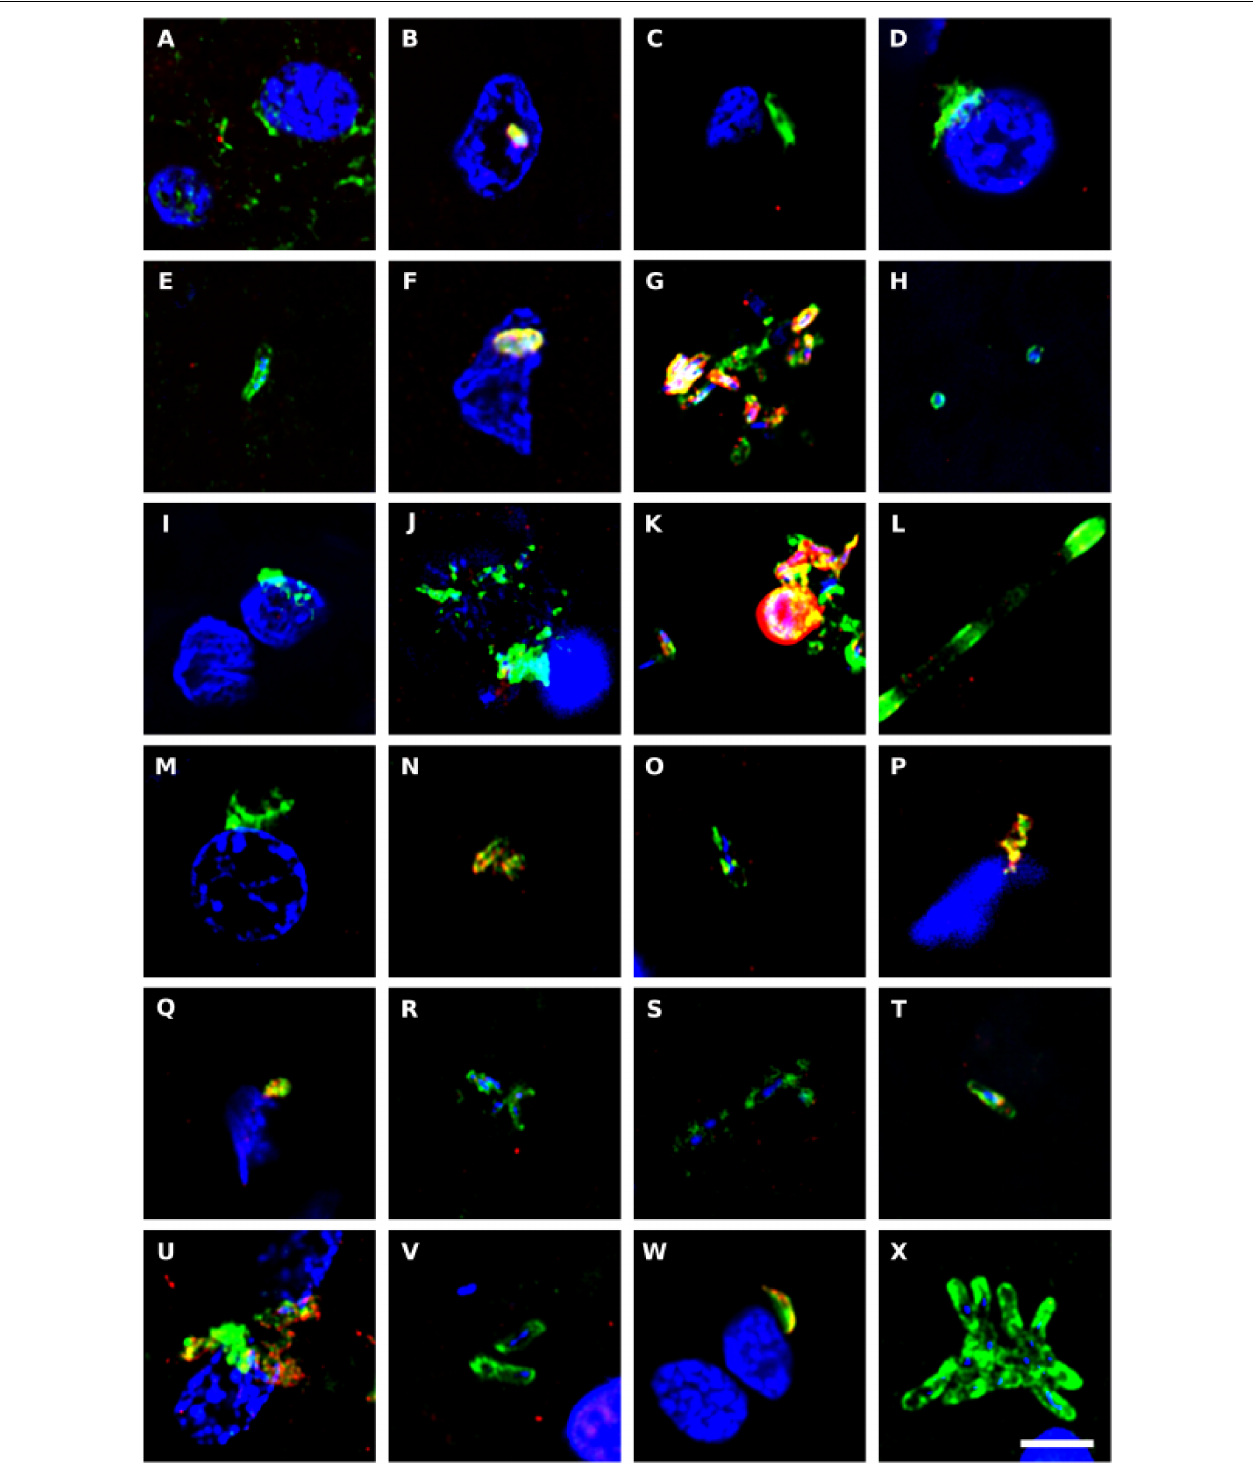
FIGURE 6 | Immunohistochemistry to detect peptidoglycan in brain tissue from ALS patients. Double immunostaining and confocal microscopy were carried out as indicated in section Materials and Methods. CNS sections were immunostained with a mouse monoclonal anti-peptidoglycan antibody (green) (1:20 dilution) and a rabbit polyclonal anti- C. albicans antibody (red) (1:500 dilution). DAPI staining of nuclei appears in blue. Scale bar: 5 µ m. (A–C) ALS2; (D–F) ALS3; (G–I) ALS4; (J,K) ALS5; (L–N) ALS6; (O) ALS1; (P) ALS7; (Q,R) ALS8; (S) ALS9; (T–V) ALS10; and (W,X) ALS11. (A,D,G,J,L,Q,S,T,W) MC section; (B,E,H,K,M,O,U,X) MD section; and (C,F,I,N,P,R,V) SC